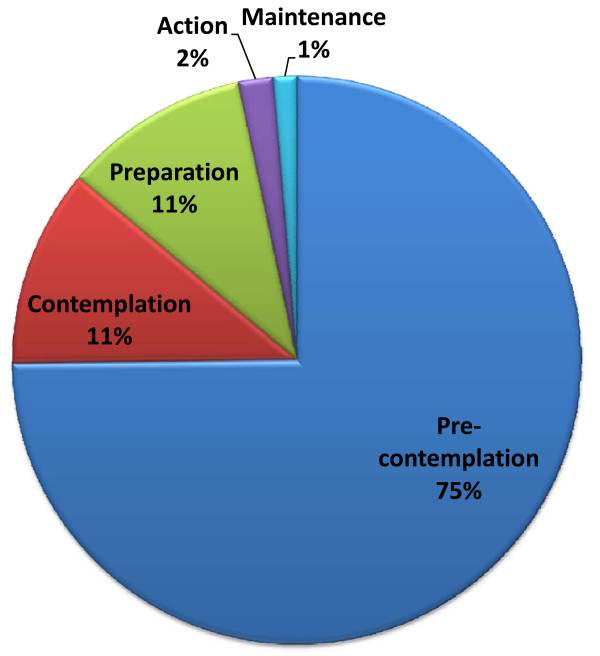
Organizational stage of change according to the transtheoretical model (n = 151) [29,65]. Stage 1: Pre-contemplation (have not thought about using the ANGCY); Stage 2: Contemplation (thinking about using the ANGCY); Stage 3: Preparation (planning programs and/or taking steps toward using the ANGCY); Stage 4: Action (currently promoting and using the ANGCY and have started some programs, < 6 mos); Stage 5: Maintenance (currently promoting and using the ANGCY and have started some programs, > 6 mos). ANGCY, Alberta Nutrition Guidelines for Children and Youth.